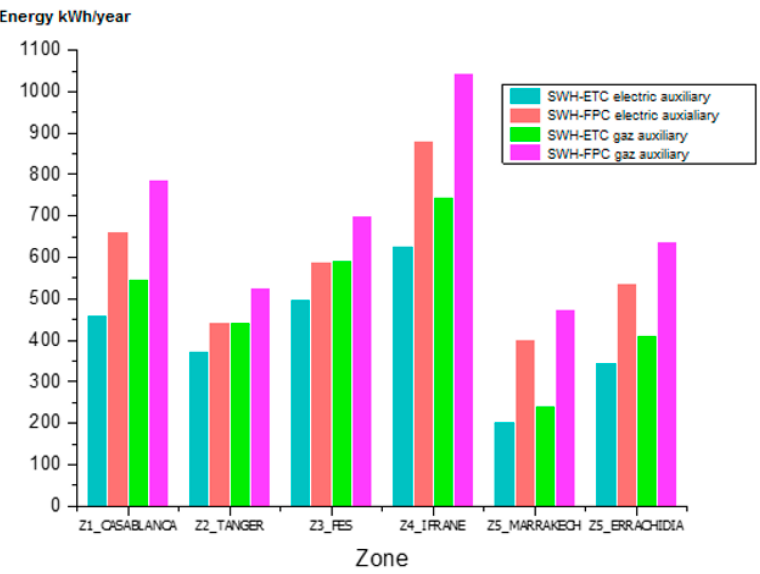
Figure 15. Annual energy of the backup system for high demand of hot water.